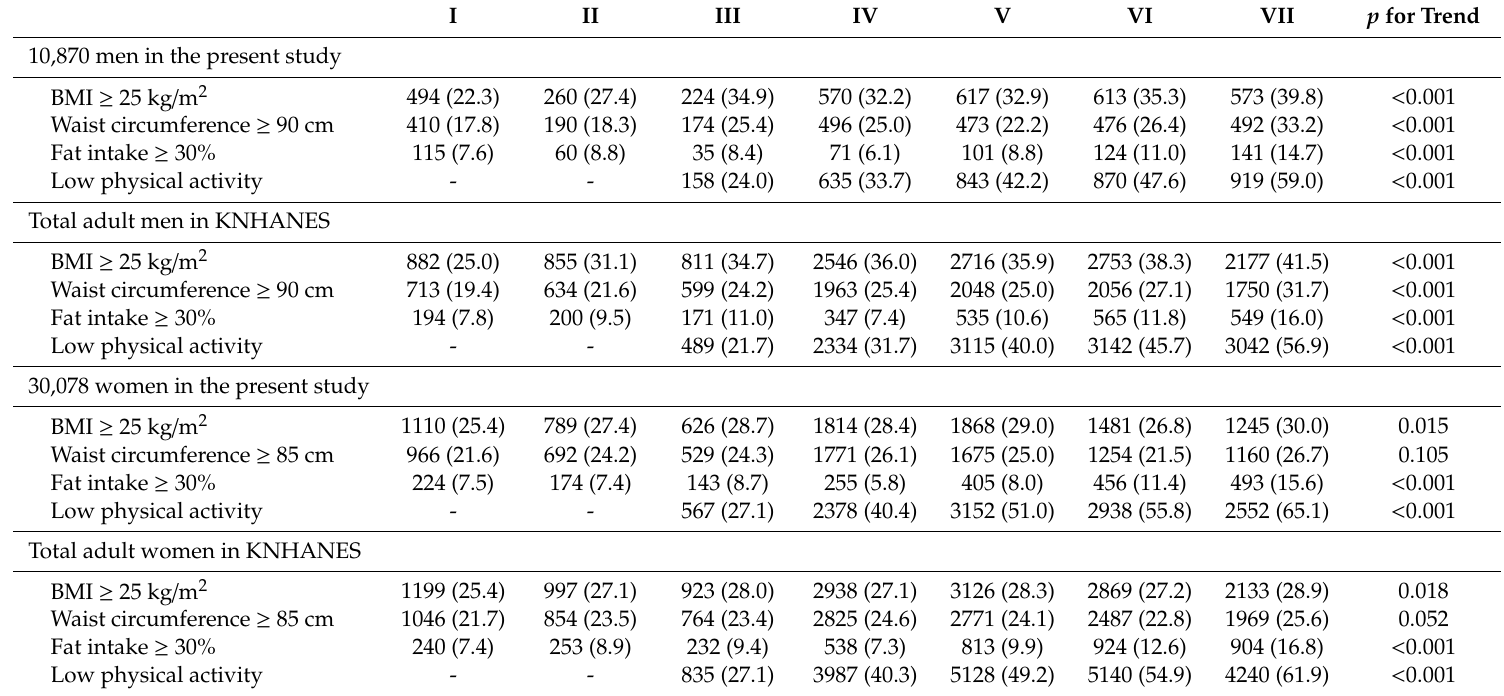
Table 2. Comparison of basic characteristics between the study population and the total adults in KNHANES waves